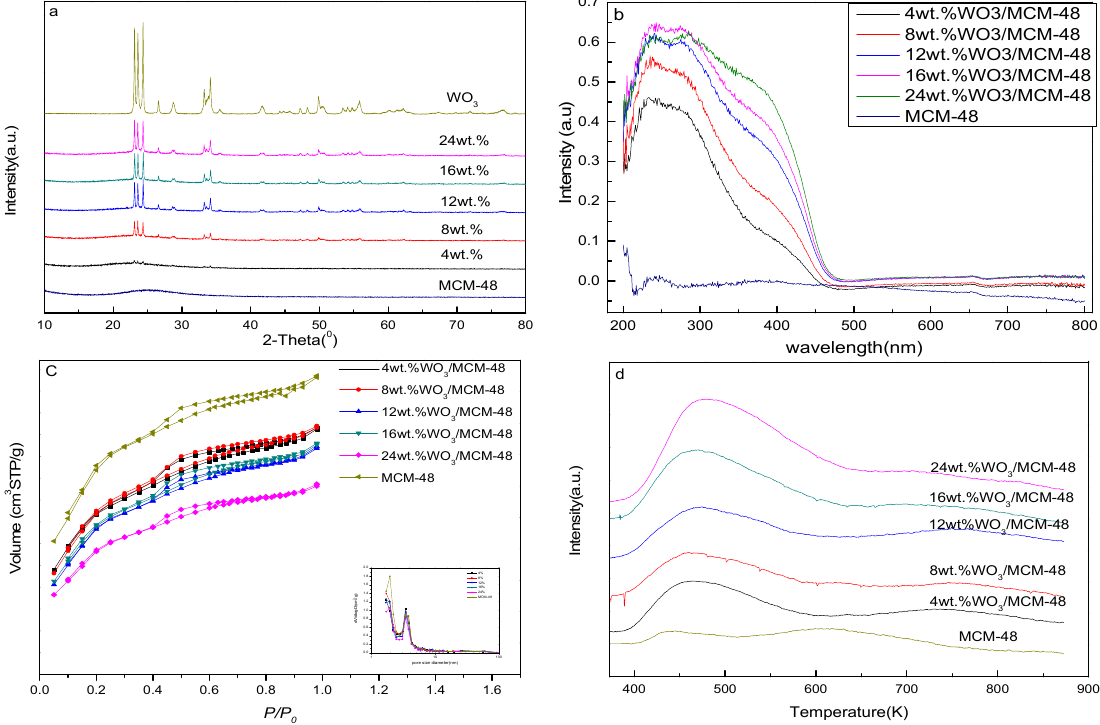
Figure 1. Structural characteristics of catalysts with different loading. ( a ) XRD patterns of catalysts, ( b ) UV-vis DRS of catalysts, ( c ) N 2 adsorption-desorption isotherms of catalysts, ( d ) NH 3 -TPD of catalysts. Table 2. Characteristics of W-based catalysts.